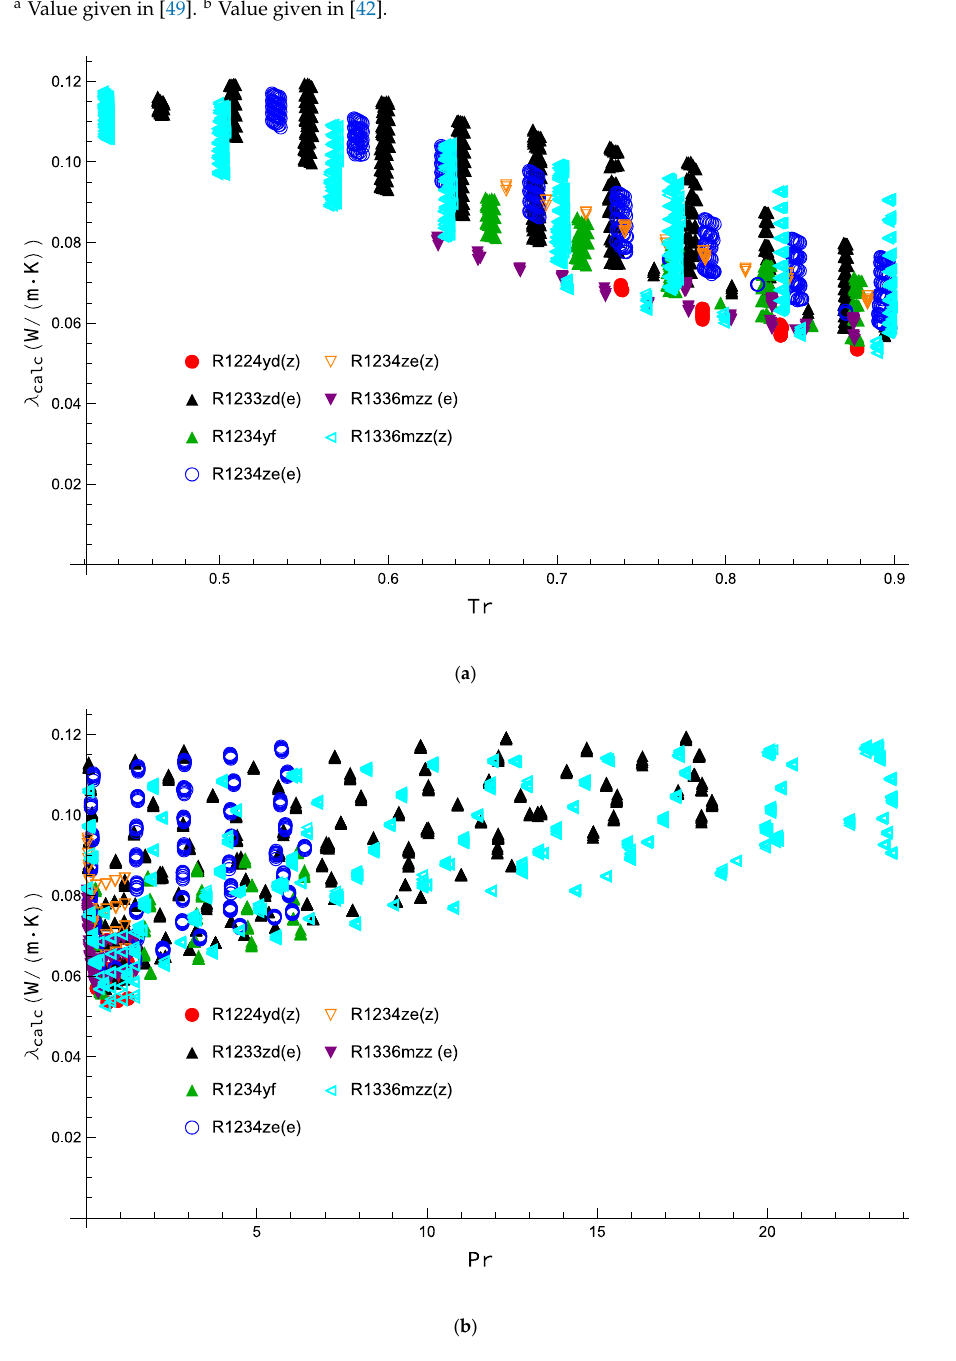
Figure 1. Liquid thermal conductivity behavior of the analyzed halogenated alkene refrigerants as a function of the reduced temperature ( a ) and the reduced pressure ( b ). Table 2. Physical properties for the studied alternative refrigerants.